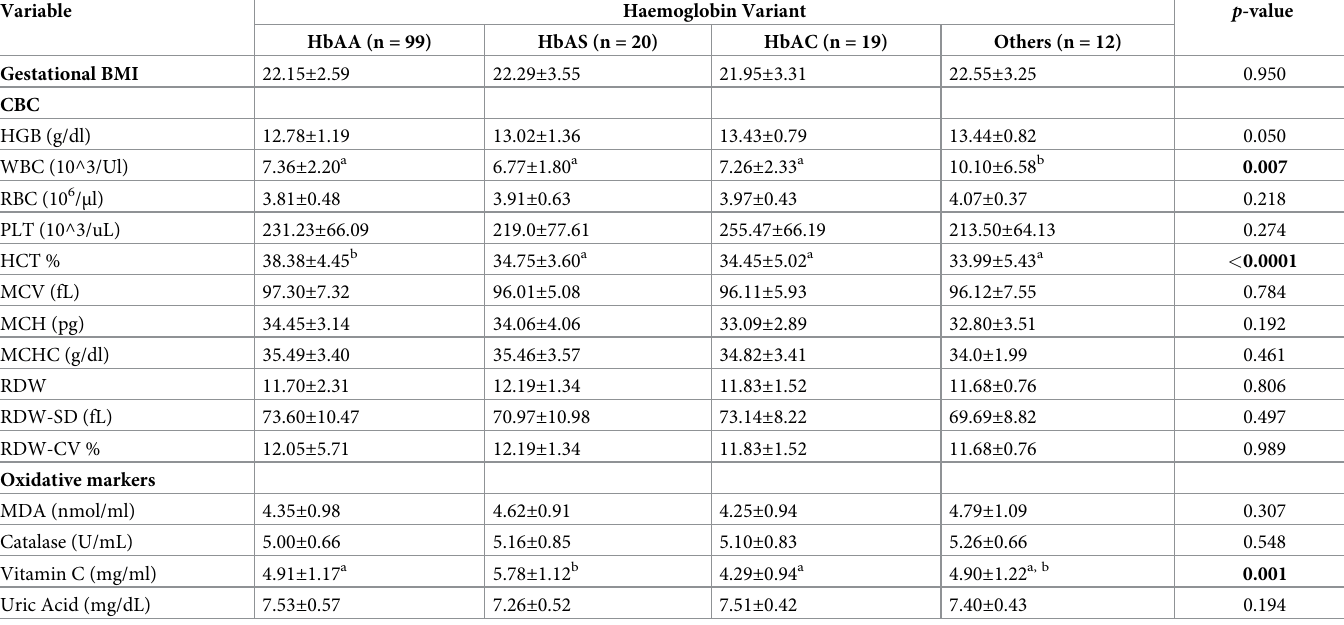
Table 2. Distribution of haematological and oxidative stress markers across the haemoglobin variants.